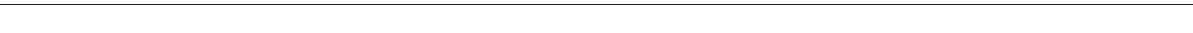
Fig. 6 The Meteor locus controls the cell fate decision between mesendoderm and neuroectoderm. a Genomic deletion in Meteor KO cells. b Expression of Meteor lncRNA in WT and Meteor KO ESCs. Bars represent average of fold change normalized to WT. p value was calculated using a two-tailed t test. (**** P < 0.0001). c GFP pro fi le at day 0 and day 3 of differentiation in WT and Meteor KO. Percentage of GFP + cells at day 0 and day 3 in WT and Meteor KO are shown to the right. Bars represent average of GFP + cells. p values were calculated using a two-tailed t test. (**** P < 0.0001). d Anti-GFP antibody staining on day 0 colonies and day 3 EBs in WT and Meteor KO (GFP: green; DAPI: blue). Scale bar represents 50 μ m. e Expression of Meteor lncRNA, Eomes , T , Mixl1 , Gsc , Mesp1 and Myh7 in WT and KO cells during cardiogenic differentiation. Trends represent average of fold change normalized to WT ESC. p values were calculated using a two-way ANOVA test. (* P < 0.05; ** P < 0.01; *** P < 0.001; **** P < 0.0001). f Heatmap of expression of representative PCGs in d0-d3 WT and Meteor KO cells. g Volcano plot representation of expressed PCGs in d0 WT and d0 Meteor KO. FPKM values of Lhx1 and Nkx6-3 are shown. Bars represent mean expression ± SEM. p values were calculated using a two-tailed t test. (* P < 0.05; **** P < 0.0001). h TUBB3 staining in neuronal-like day 14 WT and Meteor KO cells. (TUBB3: green; DAPI: blue). Scale bar represents 50 μ m. Percentage of the TUBB3 positive area is shown below. Bars represent average of percentage. p value was calculated using a two-tailed t test. Expression of Nestin and Nefm in d0-d14 WT and Meteor KO cells. Bars represent average of fold change normalized to day0 WT. p values were calculated using a two-tailed t test. (** P < 0.01; *** P < 0.001). i H3K27Ac and H3K4me3 enrichment at enhancers and promoters of Nkx6.3, Lhx1, Neurog3 and Eomes in d0-d3 WT and Meteor KO cells. Bars represent average of percentage of input. p values were calculated using a two-tailed t test. (* P < 0.05; *** P <